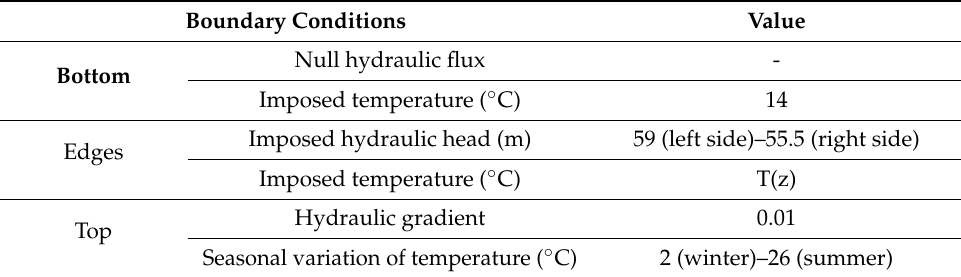
Table 4. Thermal and hydraulic boundary conditions.